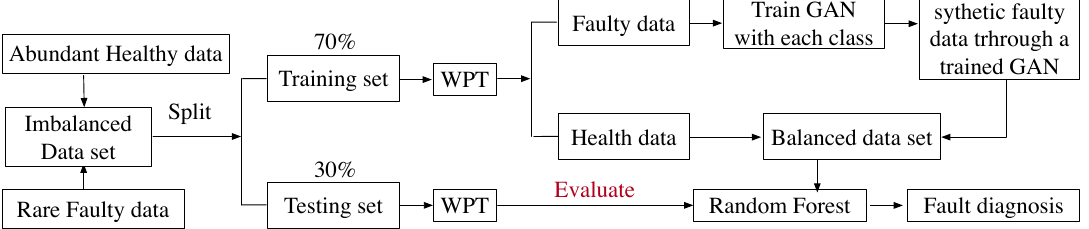
Figure 5. The flow chart of the procedure of the proposed